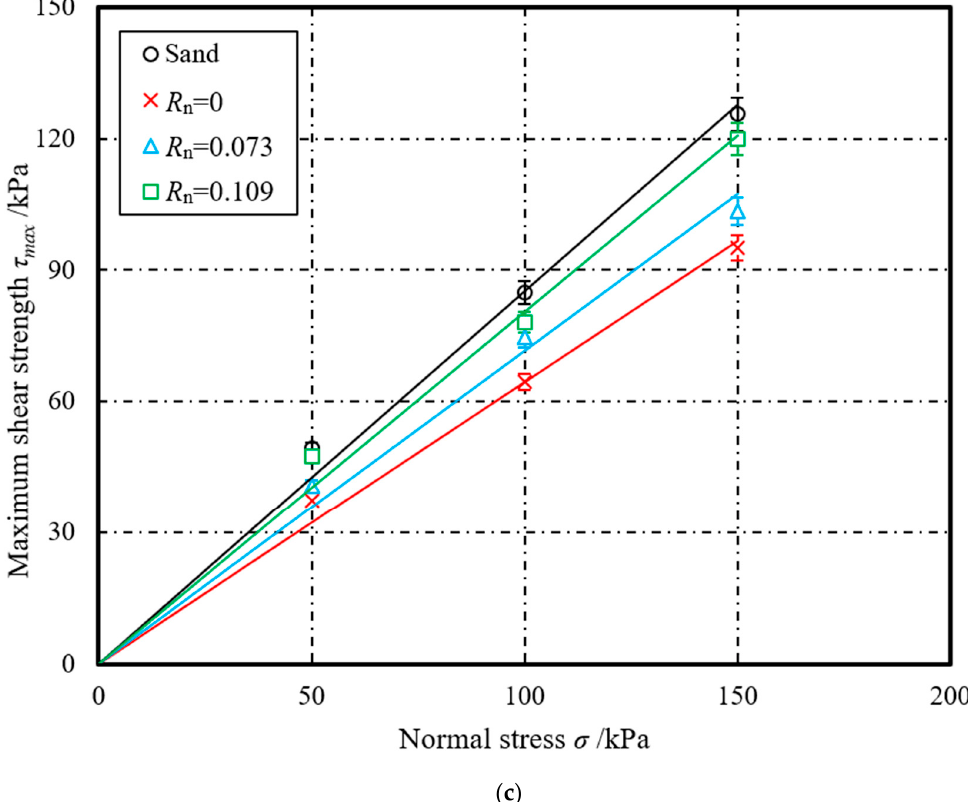
Figure 8. Failure envelopes of the pure sand shear tests and the interface shear tests: ( a ) 0.63–1.25 mm sand; ( b ) 1.25–2.50 mm sand; ( c ) 2.50–5.00 mm sand.